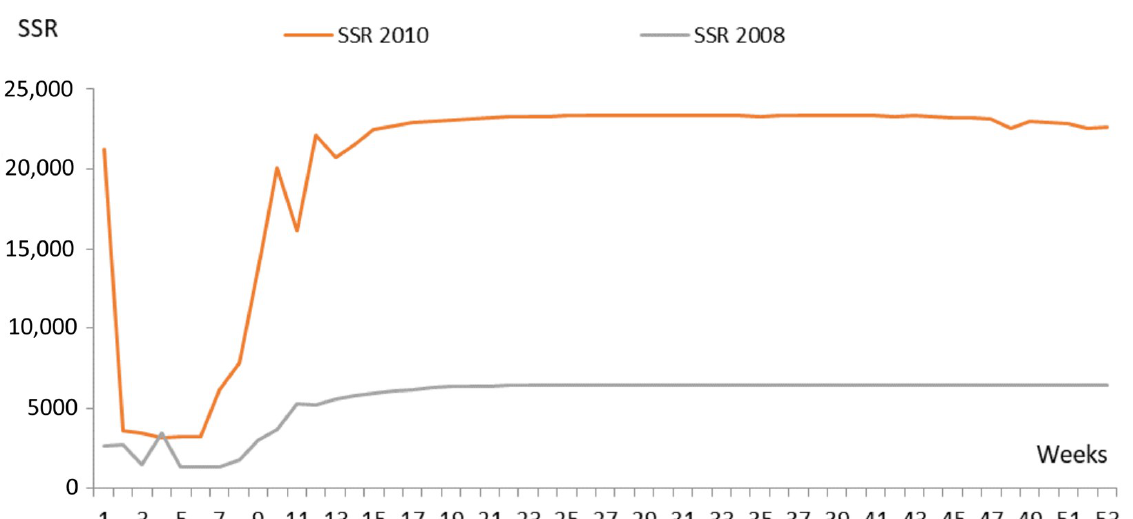
Figure A1. Goodness of fit of malaria metapopulation model according to the assumed lag between rainfall and mosquito bites. Calibrations were undertaken on 2008 and 2010 transmission seasons. Optimization function computing the sum of squared residuals (SSR) were minimized for 6 weeks lag.